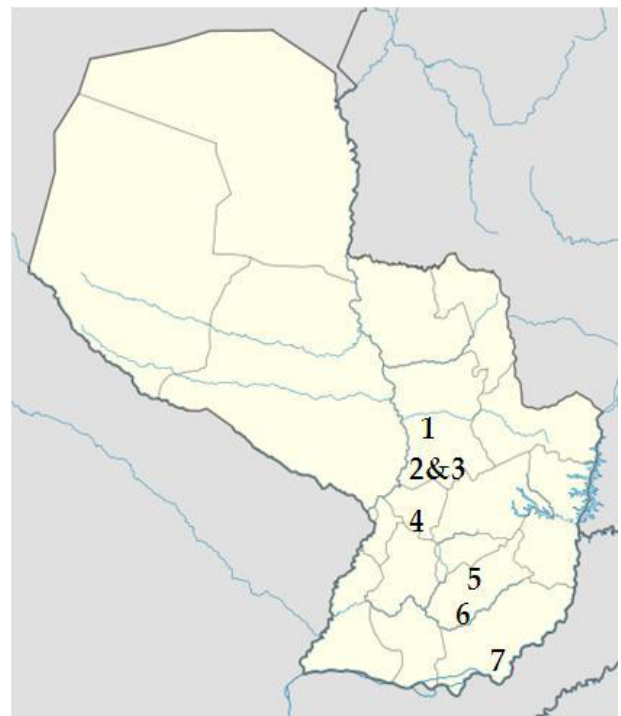
Fig. 1 . Study system, as described in Grossman